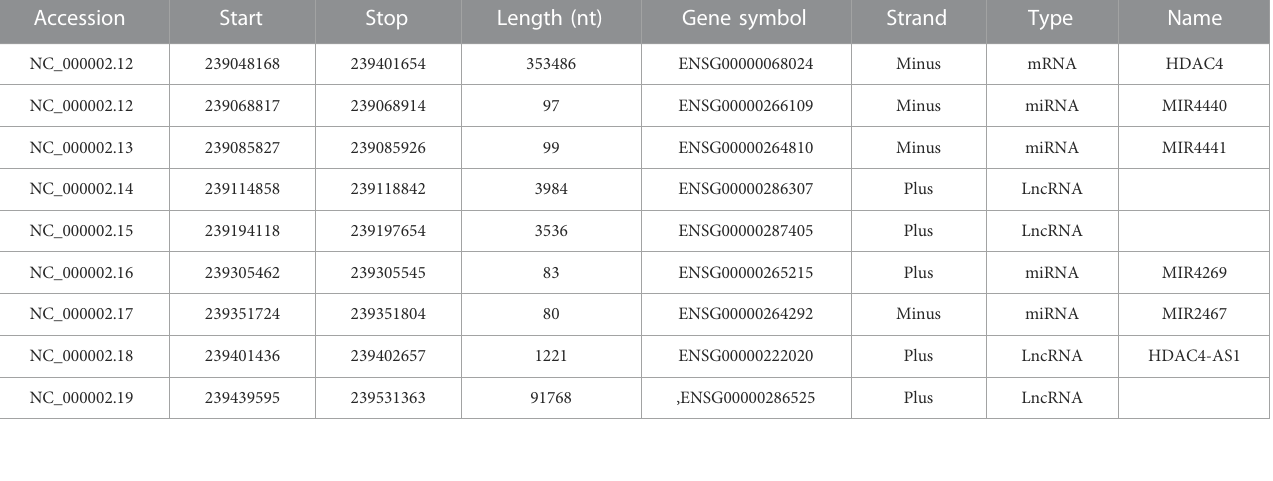
TABLE 1 The HDAC4 locus. Genes transcribed from the HDAC4 locus are indicated. Data were obtained from https://www.ncbi.nlm.nih.gov/gene/9759 (Ensembl release 107).